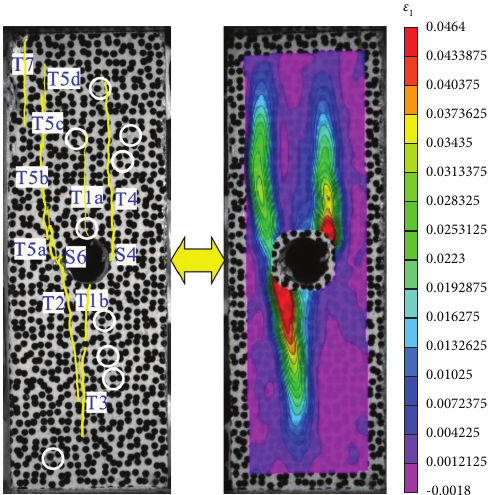
Figure 16: Crack propagation process and failure pattern of the intact specimen containing an opening.